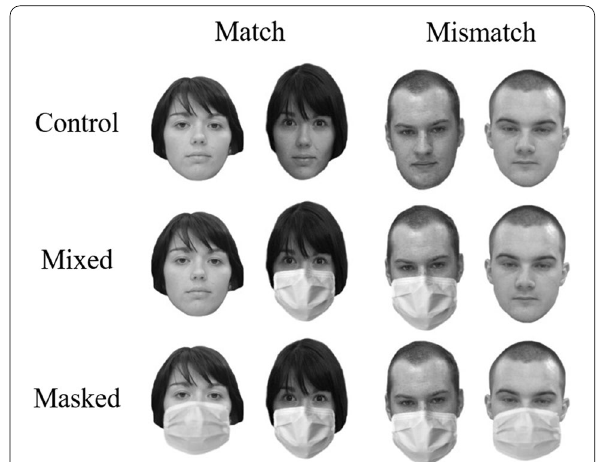
Fig. 1 Examples of the control, mixed and masked conditions for match and mismatch trials of the GFMT [ reproduced and adapted with permission from the copyright